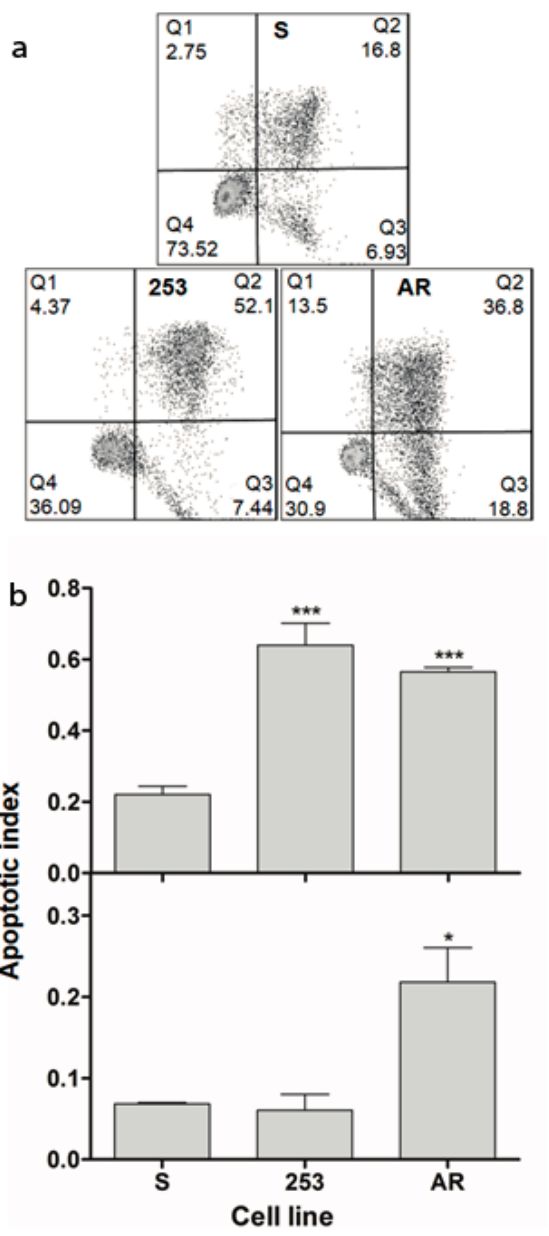
Figure 4. UV-induced apoptosis in mouse 32D transfected with the BCR-ABL1 gene: sensitive (S) and resistant to imatinib or cells displaying imatinib resistance caused by the Y253H mutation in BCR-ABL1 (253) or incubation of the sensitive cells with increasing doses of imatinib (AR). Cells were irradiated with UV light at 35 J/m 2 at room temperature at a dose rate of 0.12 J/(m 2 ·s). Apoptosis was assayed by flow cytometry with Annexin V-propidium iodide staining after a 24 h post-incubation. ( a ) Representative scatter plots for cells irradiated with UV; numbers in quadrants represent percentage of cells in early apoptosis (Q3), late apoptosis and necrosis (Q2) and live cells (Q4); ( b ) Apoptotic index calculated as percentage of either Q3 + Q2 cells (upper bar graph) or Q3 cells (lower graph) cells in 5 × 10 4 cells. Data are expressed as means of three independent experiments, presented is mean ± standard deviation (SD), * p < 0.05, *** p < 0.001 as compared with S